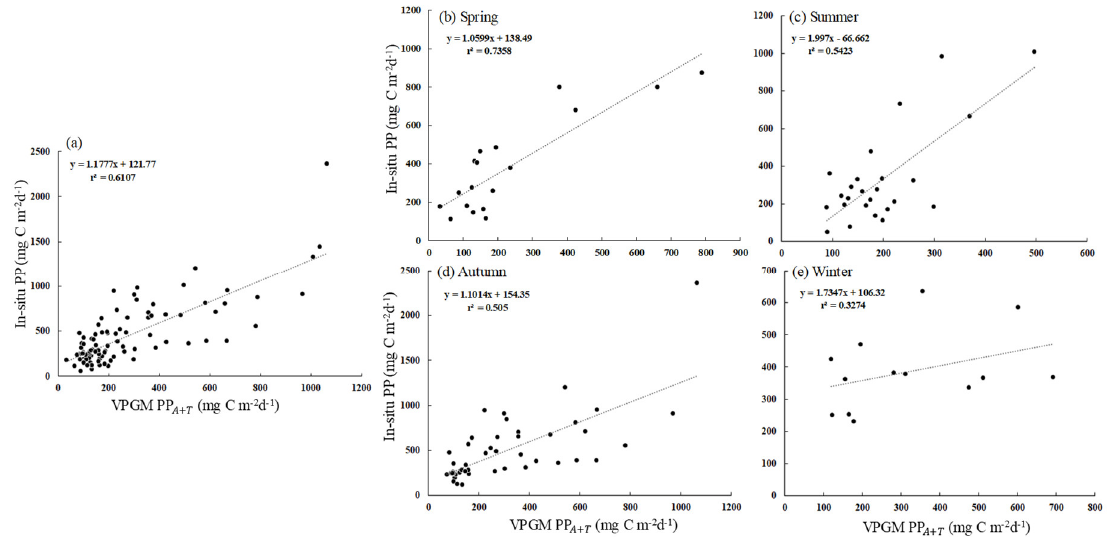
Figure 5. Relationship between the VPGM PP A&T and in situ PP for ( a ) the whole year, ( b ) spring, ( c ) summer, ( d ) autumn, and ( e ) winter during the study period.